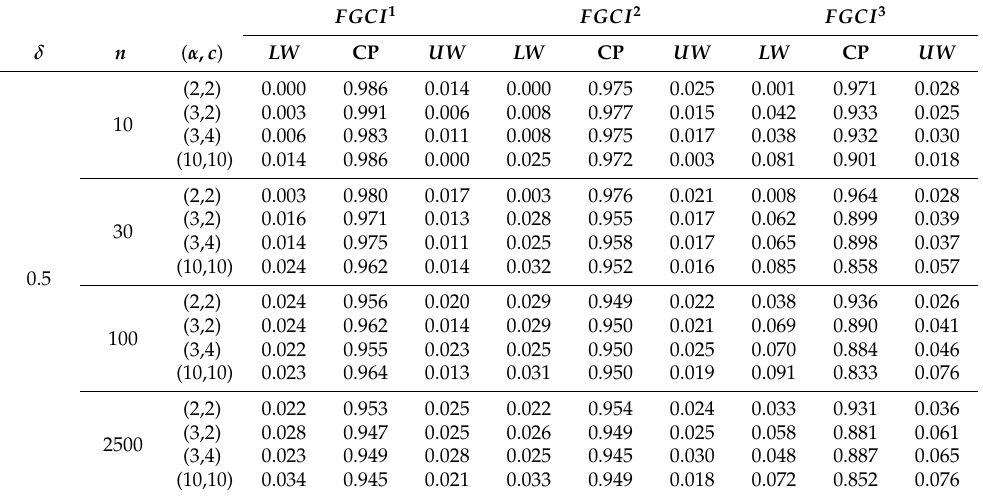
Table 2. Coverage probabilities for the mean of a sample with large proportions of